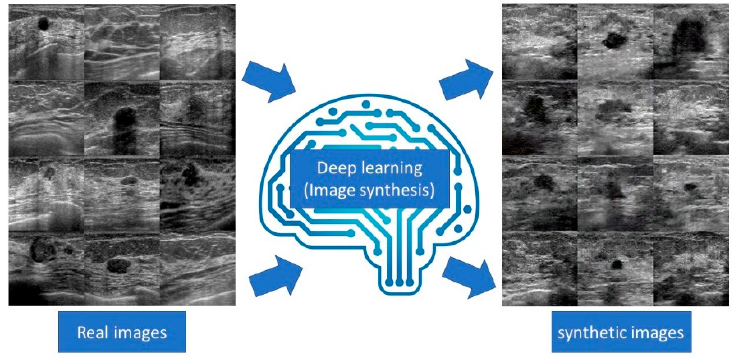
Figure 7. Diagram of image synthesis for breast ultrasound.